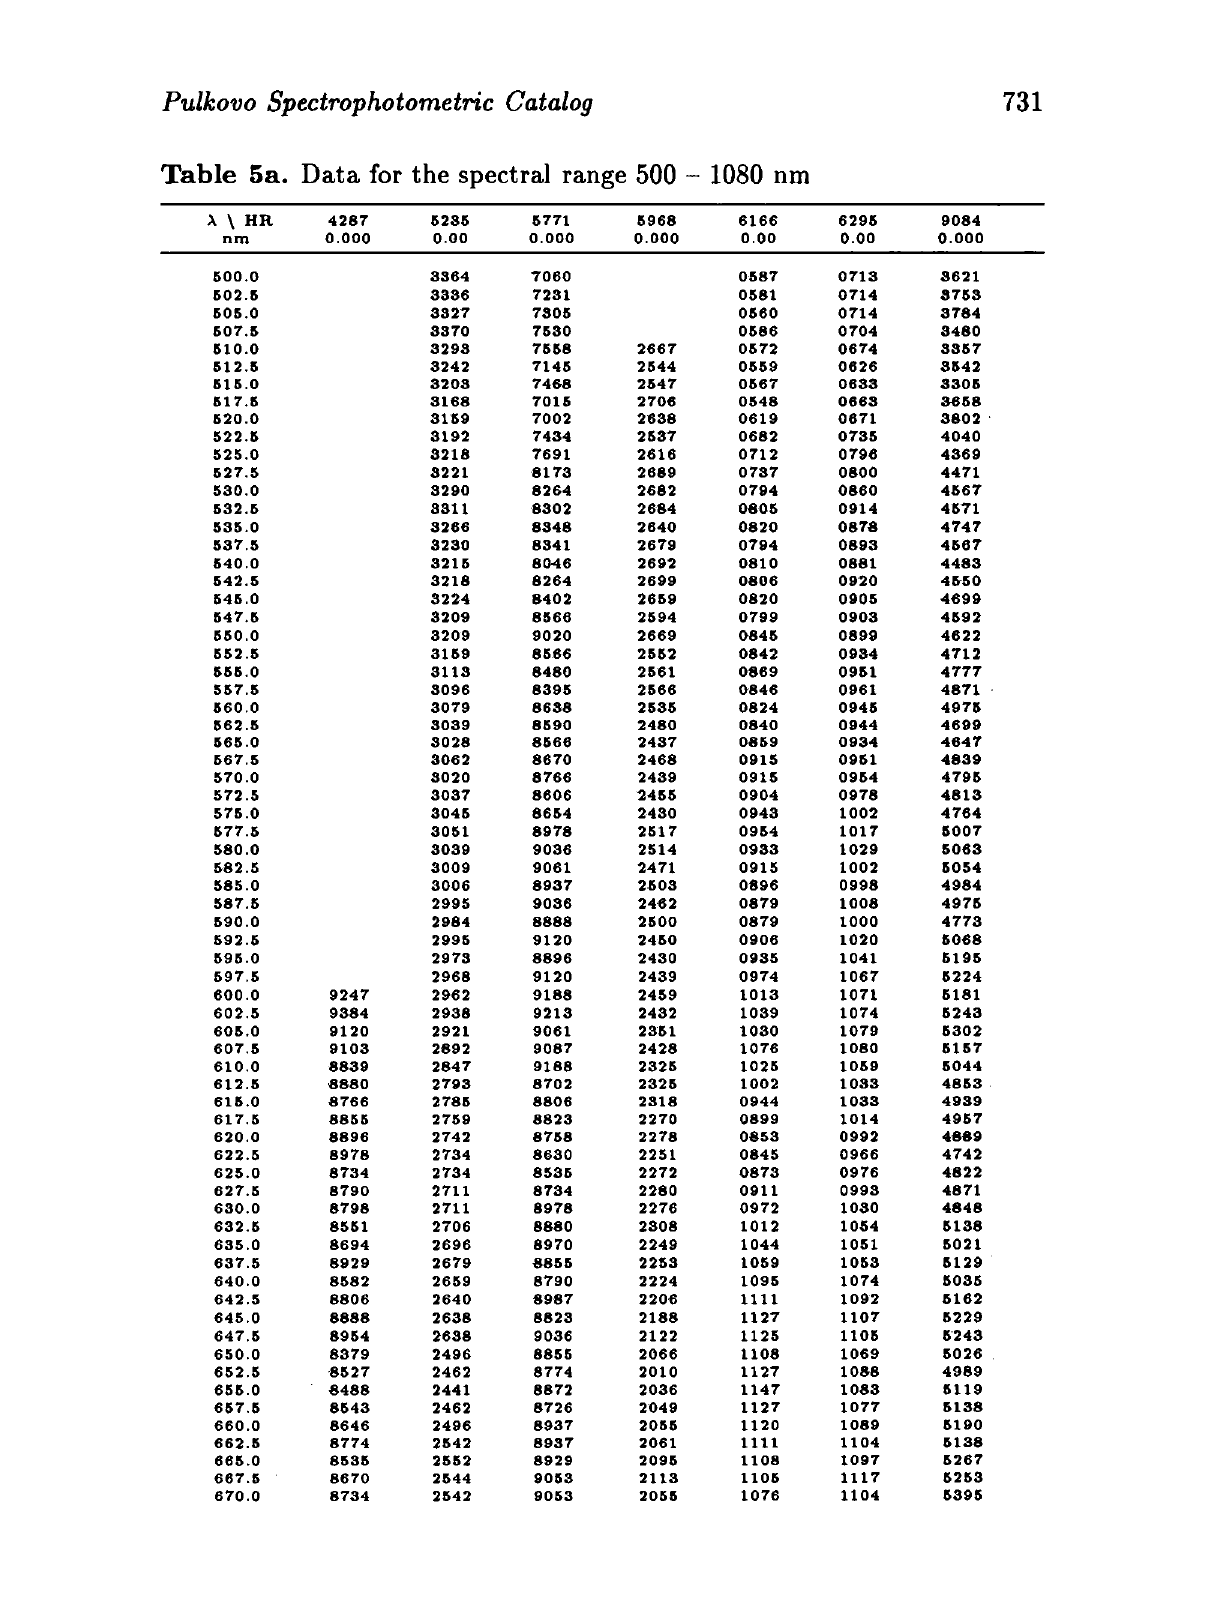
Table 5a. Data for the spectral range 500 - 1080 nm A \